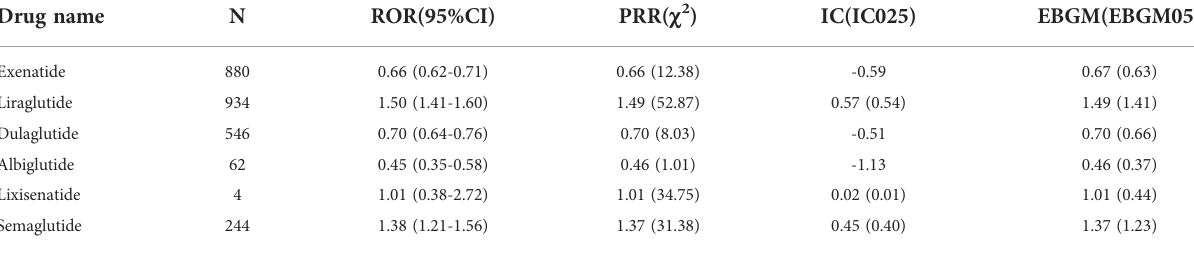
TABLE 4 Association of different GLP-1RAs with acute kidney injury.